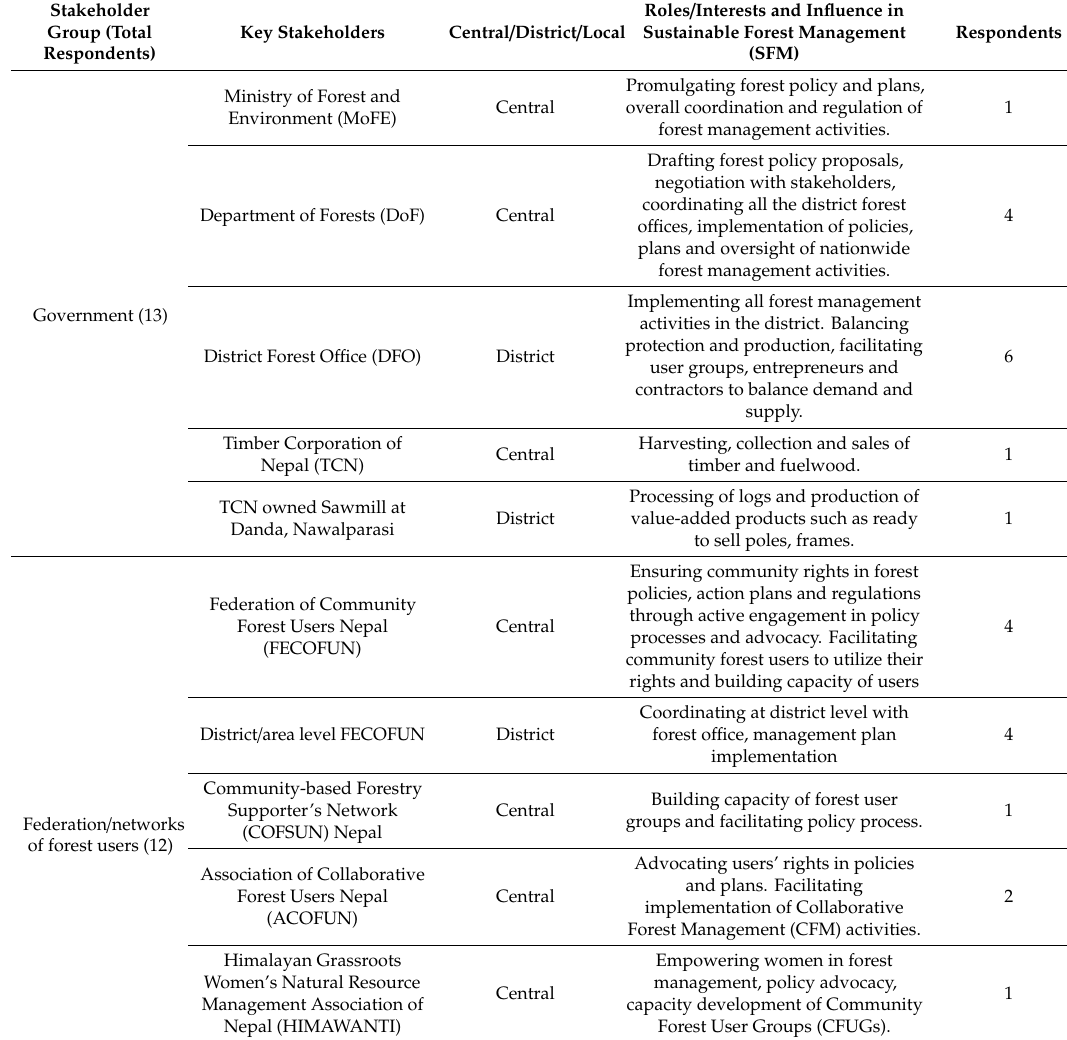
Table 1. Identified key stakeholders, their roles / interests and number of